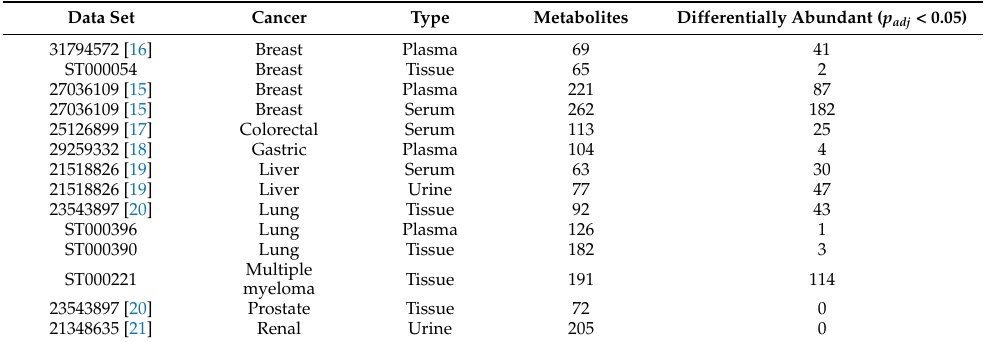
Table 2. Overview of the number of significantly differentially abundant metabolites per data set and cancer type (Benjamini–Hochberg adjusted p -value p adj <